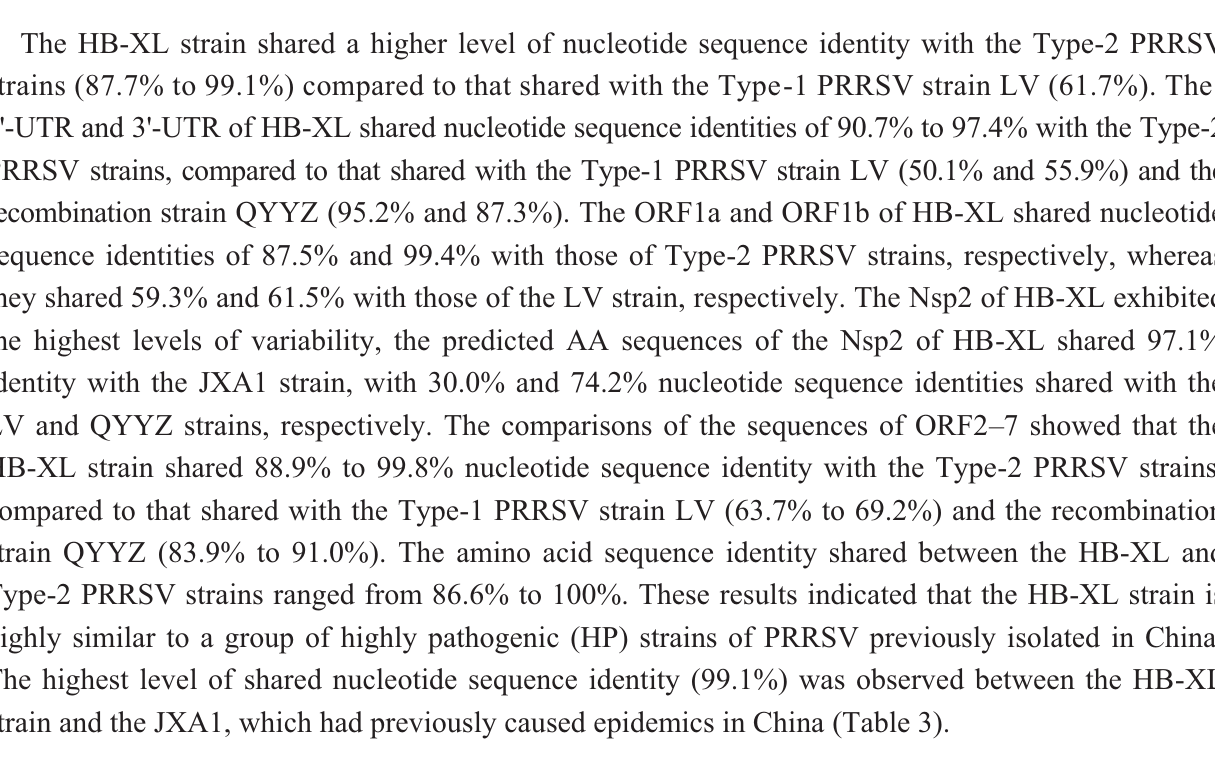
Table 3. Nucleotide and deduced amino acid identities of HB-XL compared with those